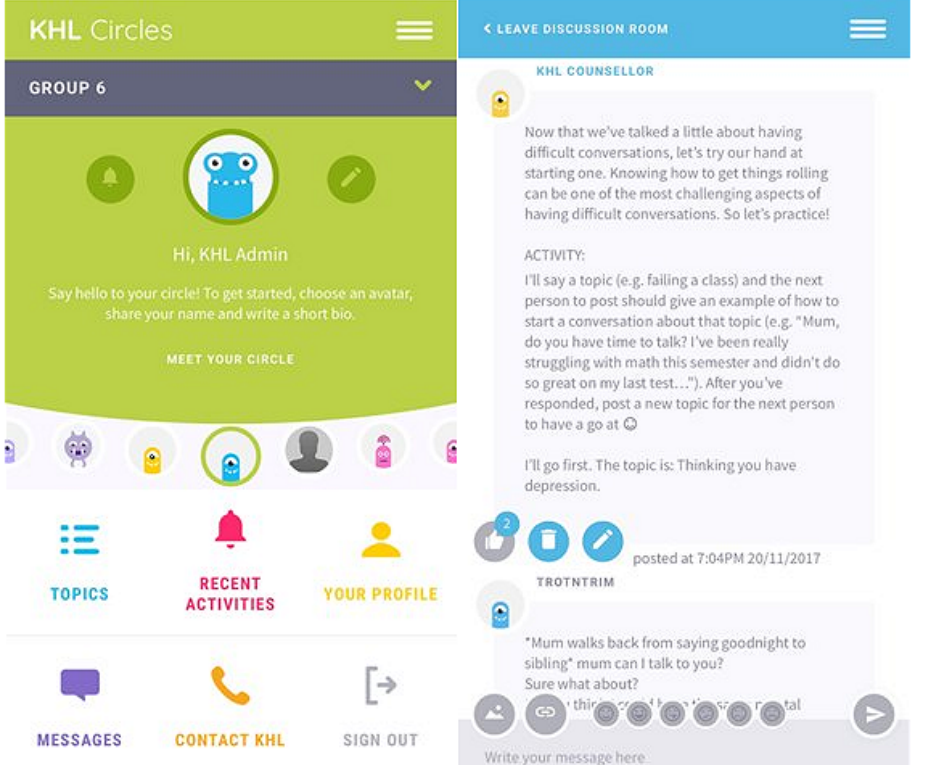
Figure 1. Kids Helpline Circles (KHL Circles) mobile phone interface